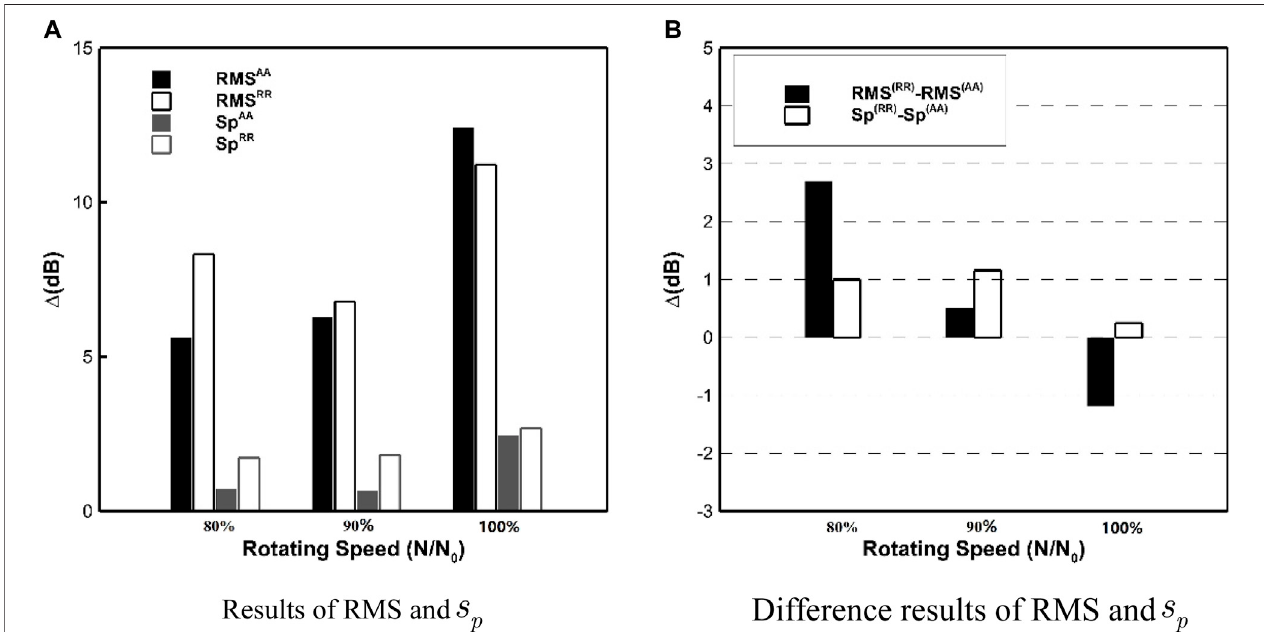
FIGURE 14 | RMS and s p of sound pressure measurement signals measured by radial rakes and axial arrays. (A) Results of RMS and s p . (B) Difference results of RMS and s p .